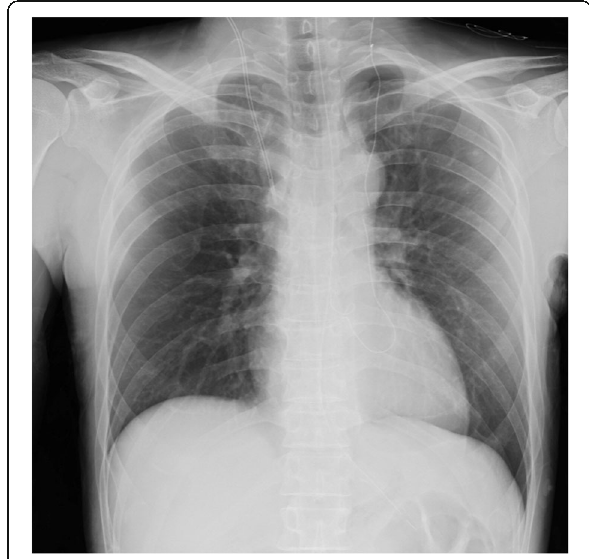
Fig. 4 Chest X-ray 5 h after surgery showing a fully expanded left lung without re-expansion pulmonary